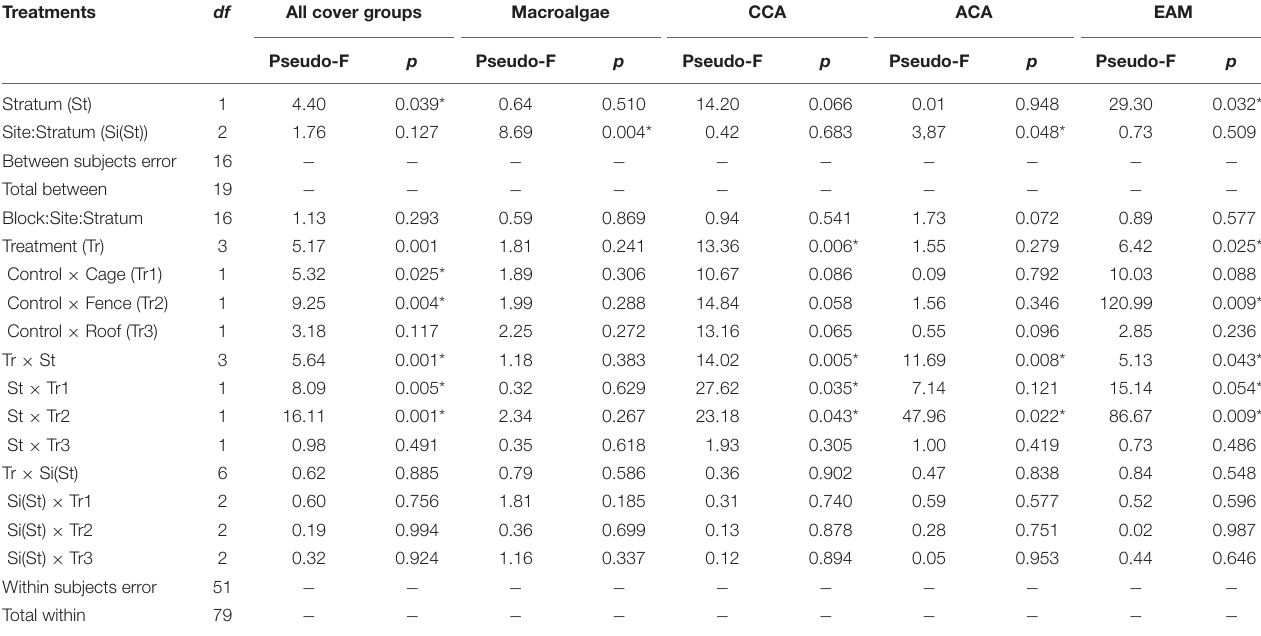
TABLE 1 | Comparative results of PERMANOVA for substrate cover composition and dominant groups among treatments, depth strata and site at Arraial do Cabo (RJ, Brazil) rocky reefs. Treatments df All cover groups